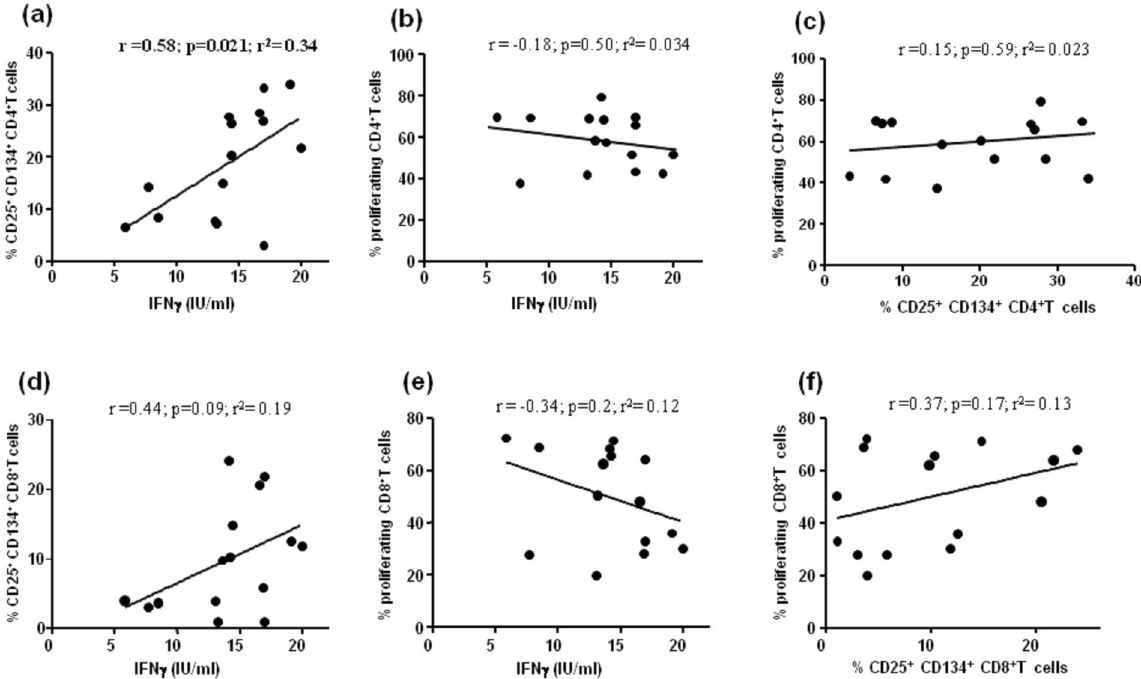
Figure 4. Correlations between IFN γ secretion, co-expression of activation markers, and lymphocyte proliferation in response to phytohemagglutinin. The ex vivo immunologic assays of all IMID subjects were correlated using Pearson correlation coefficients. (a) IFN γ response to phytohemagglutinin (PHA) was positively correlated with the frequency of CD25 + CD134 + CD4 + T cells (r = 0.58, p = 0.028, r 2 = 0.34), (b) but not with the CD4 + T cells proliferating in response to PHA (r = − 0.18, p = 0.5, r 2 = 0.034). ( c) Lack of correlation between frequencies of CD25 + CD134 + CD4 + T cells and CD4 + T cell proliferation (r = 0.15, p = 0.5, r 2 = 0.023). ( d–f) Lack of correlation in all CD8 + T cell analysis.